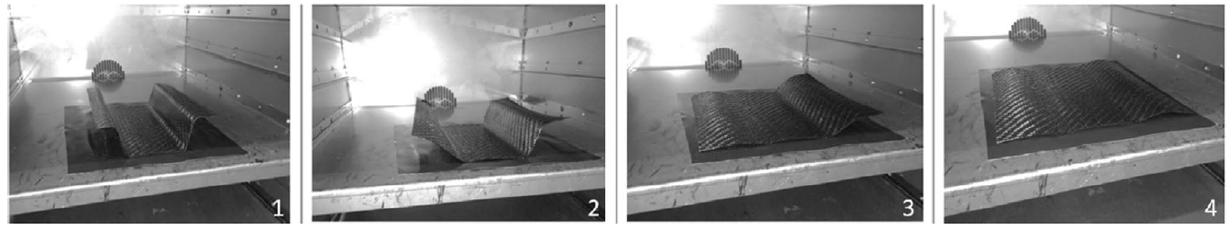
Fig. 2 Steps of the reforming process in the convection oven